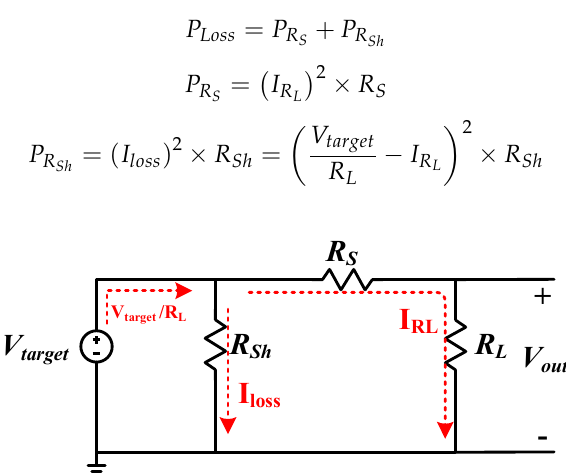
Figure 14. Simplified model for power loss calculations.